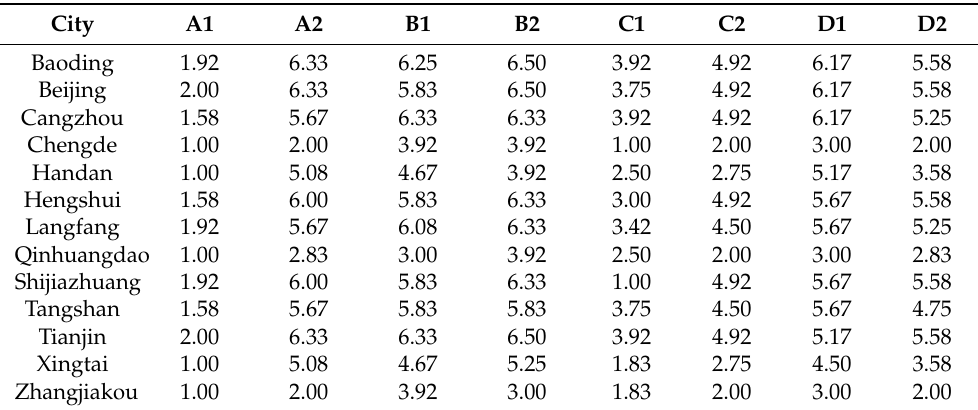
Table 3. Comparison of the average number of independent paths of cities in different